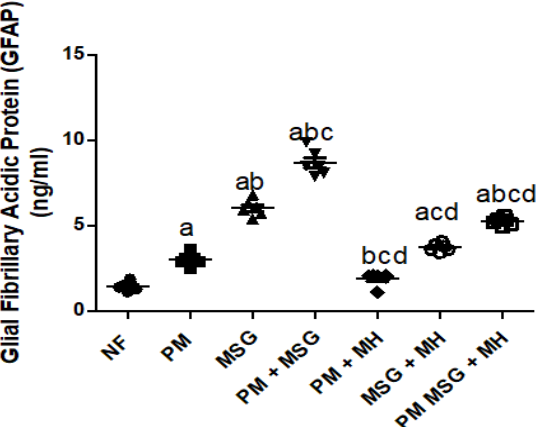
Figure 9. MH correct GFAP brain content of PM and/or MSG—fed rat pups. Effect of 60 mg/kg MH on brain GFAP content of PM diet and/or 0.4 g/kg MSG. Data presented as mean ± SEM ( n = 6). a–d represents significant difference to NF, PM, MSG, PM + MSG groups, respectively, at p < 0.05. Statistical analysis was performed using one-way ANOVA, followed by Tukey’s post hoc test. [The data of the effect of MH on the control NF is not shown as it is not significant].